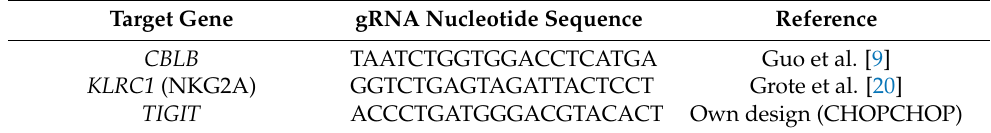
Table 1. List of sgRNAs employed in this study. Target Gene gRNA Nucleotide Sequence Reference CBLB TAATCTGGTGGACCTCATGA Guo et al. [9] KLRC1 (NKG2A) GGTCTGAGTAGATTACTCCT Grote et al. [20] TIGIT